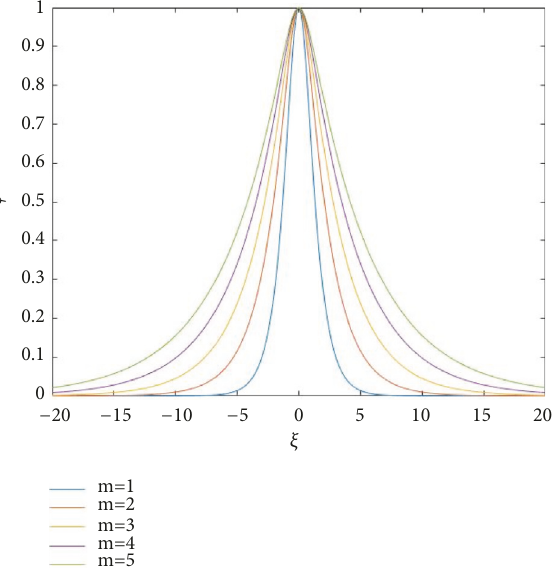
Figure 1: Bright soliton waveform of |𝜓| for various power indexes 𝑚